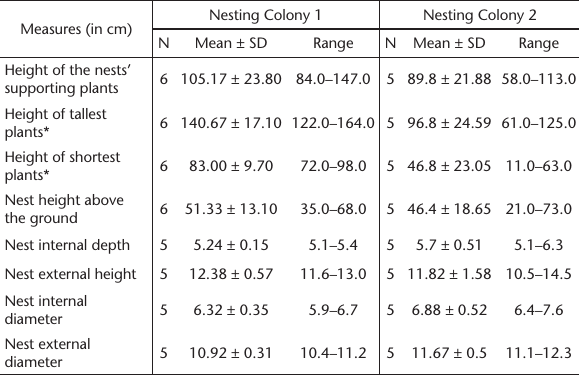
Table 1. Mean ± standard deviation (SD) of measurements of Saffron- Cowled Blackbirds’